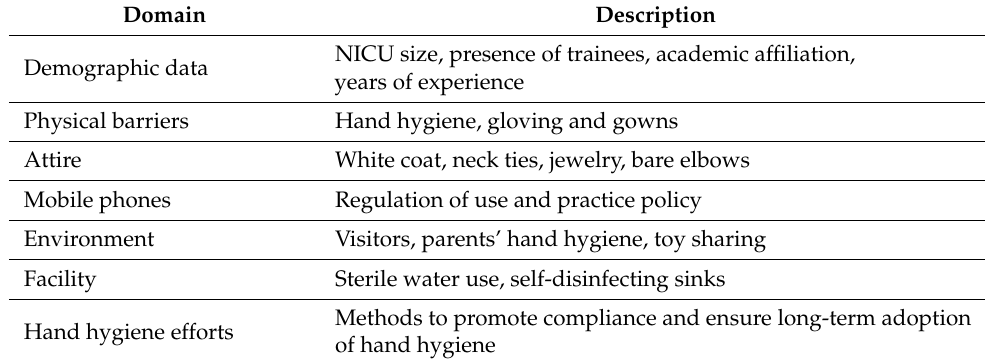
Table 1. The Domains of the Survey Questions Sent to